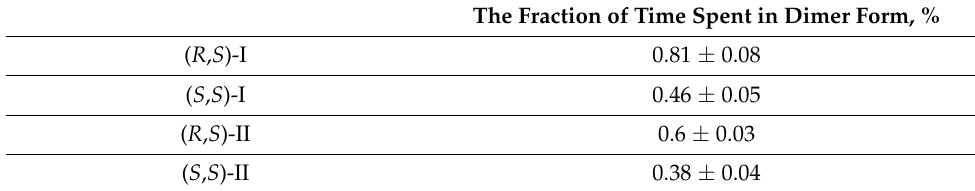
Table 7. Probability of dimer formation for various optical configurations of dyads I and II [20]. The Fraction of Time Spent in Dimer Form, %